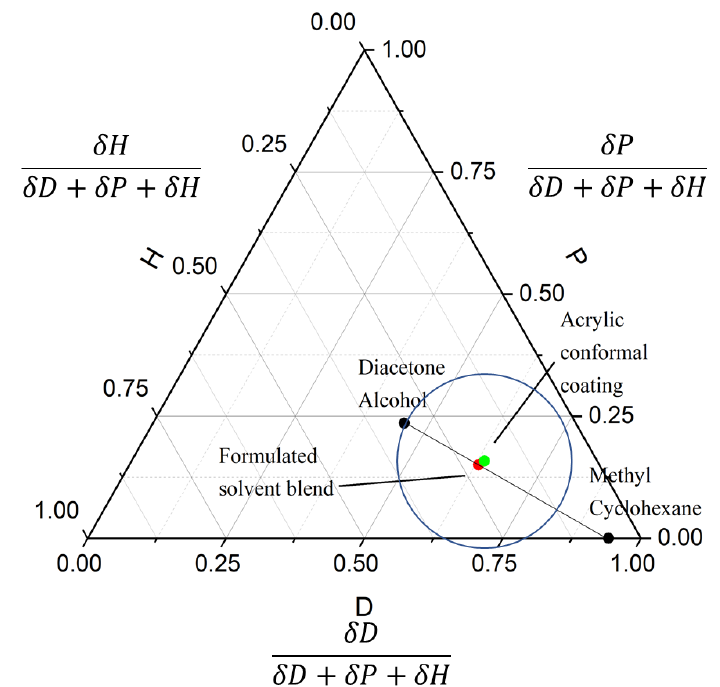
Figure 4. Triangular plot demonstrating the solvent optimization process: By combining diacetone alcohol (a weak solvent with a dwell time of 12 min) and methyl cyclohexane (a bad solvent that cannot dissolve acrylic coating after 30 min), the solvent blend (within the radius) became a good solvent (with a dwell time of 3 min, see more discussion in Table S4).